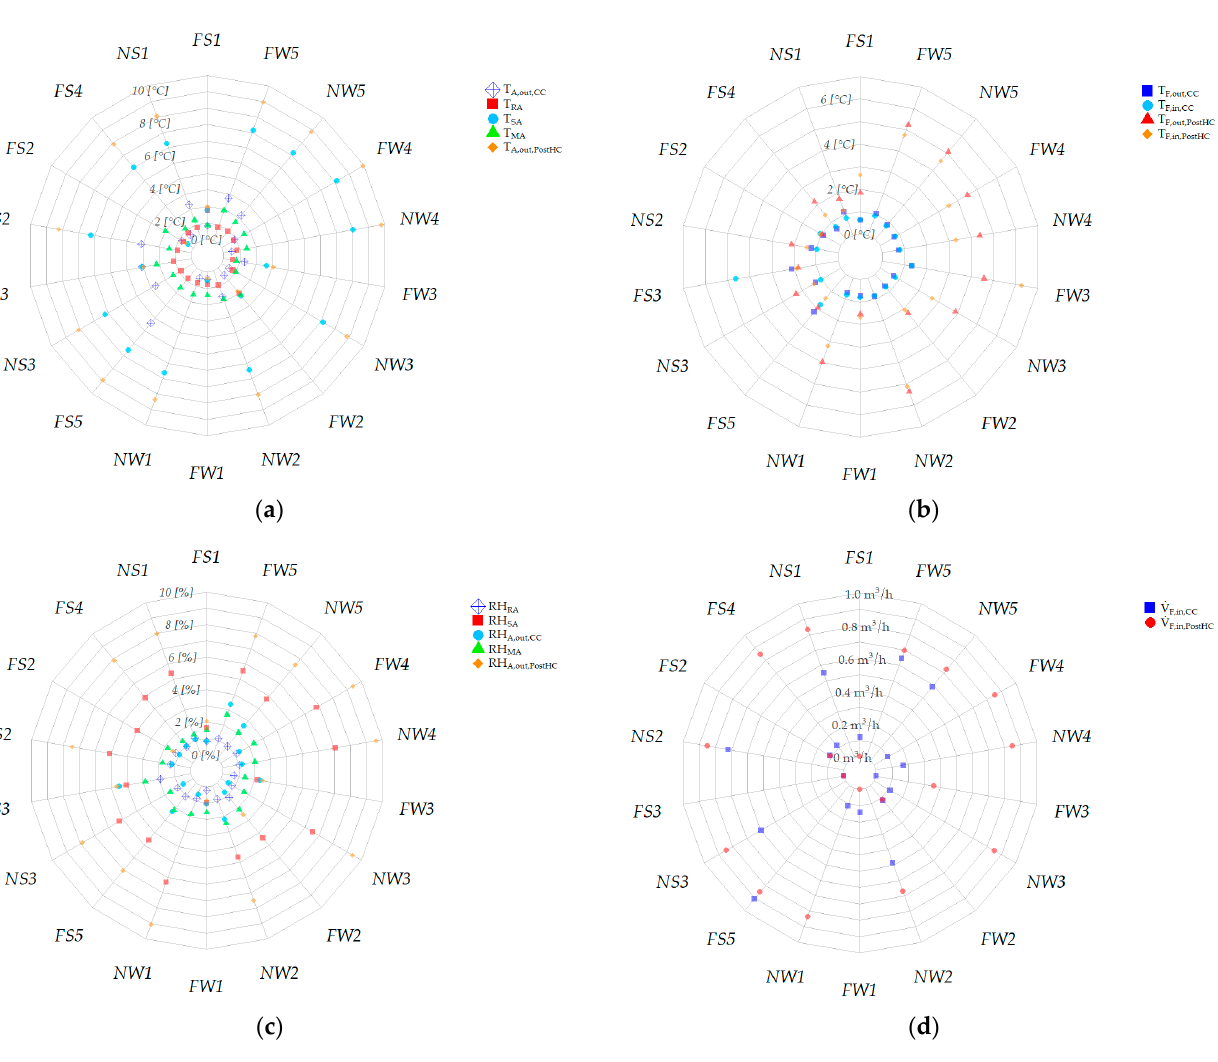
Figure 6. Arithmetic means of ( a ) air temperature, ( b ) water temperature, ( c ) air relative humidity, and ( d ) water volumetric flow rate measured during faulty and normal tests.